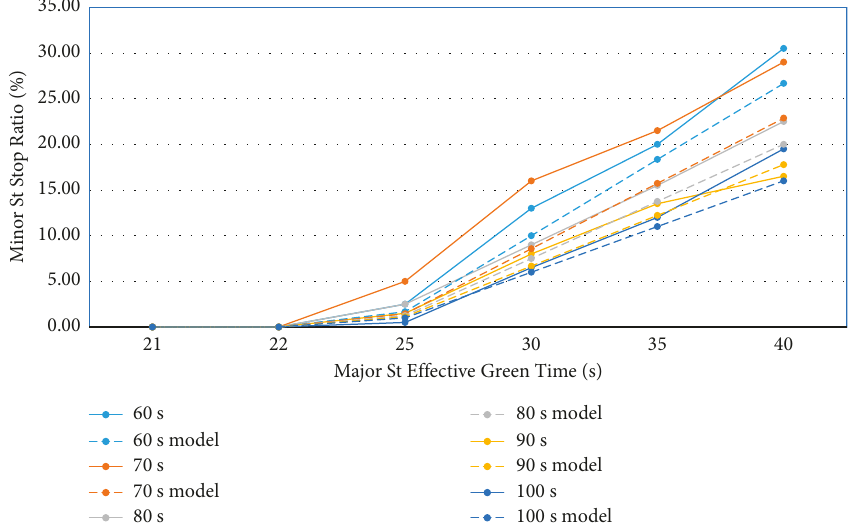
Figure 9: Minor St tolerance stop ratio of coordination plans under volume of